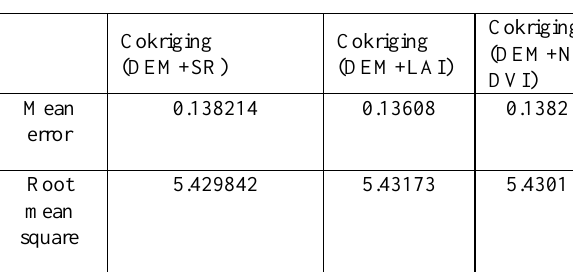
Table 4. Cokriging(DEM+SR),